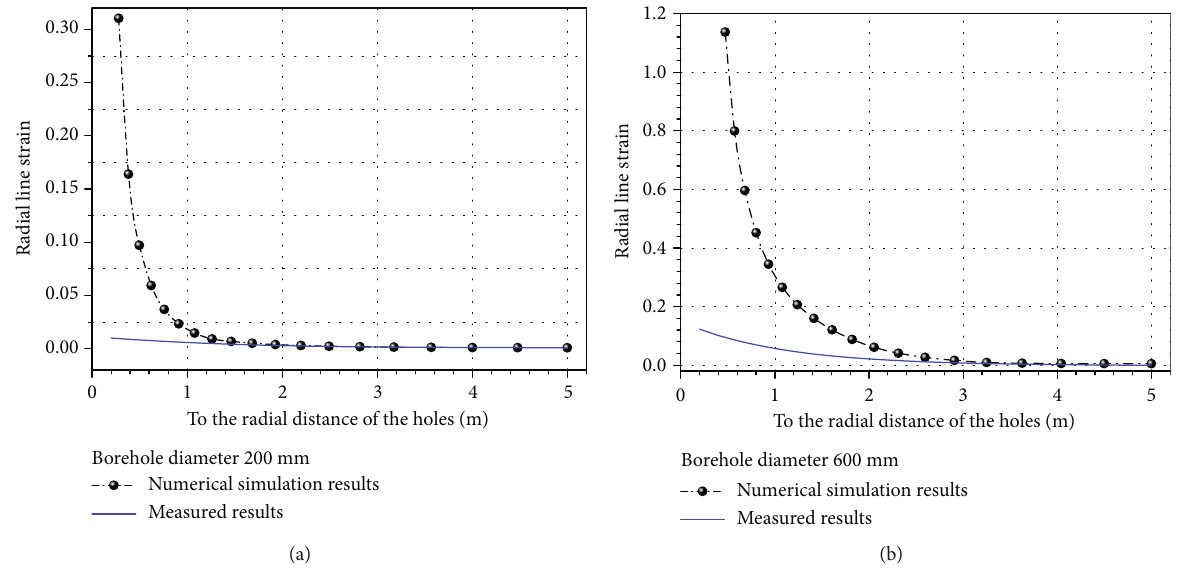
Figure 12: Comparison between curves conducted from onsite measurement and numerical